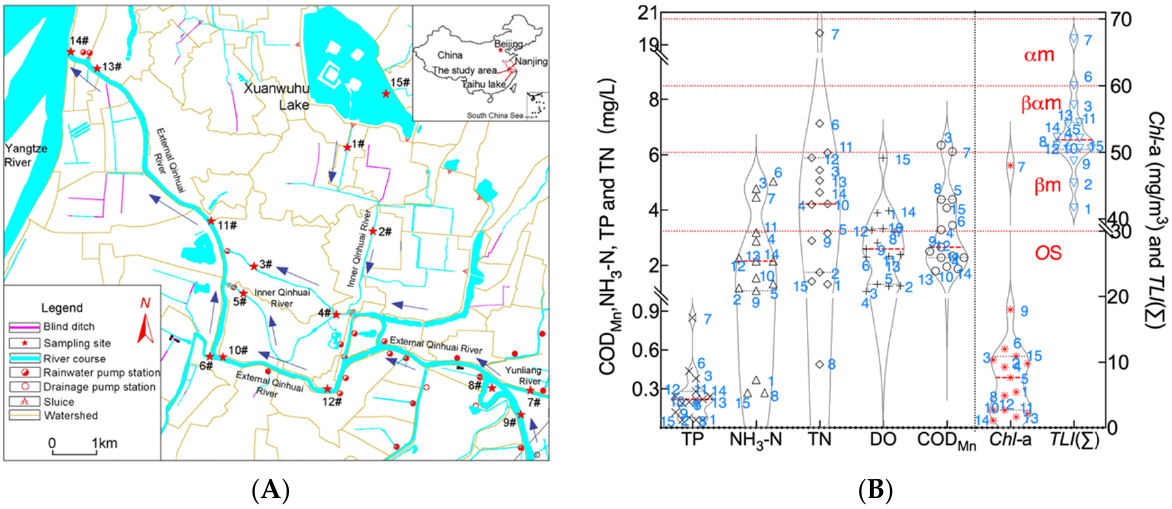
Figure 1. Sampling sites ( A ) and the corresponding physicochemical indexes of water samples ( B ) in the study area in Nanjing City, China. Note: (1) The codes for each sampling site are as follows: